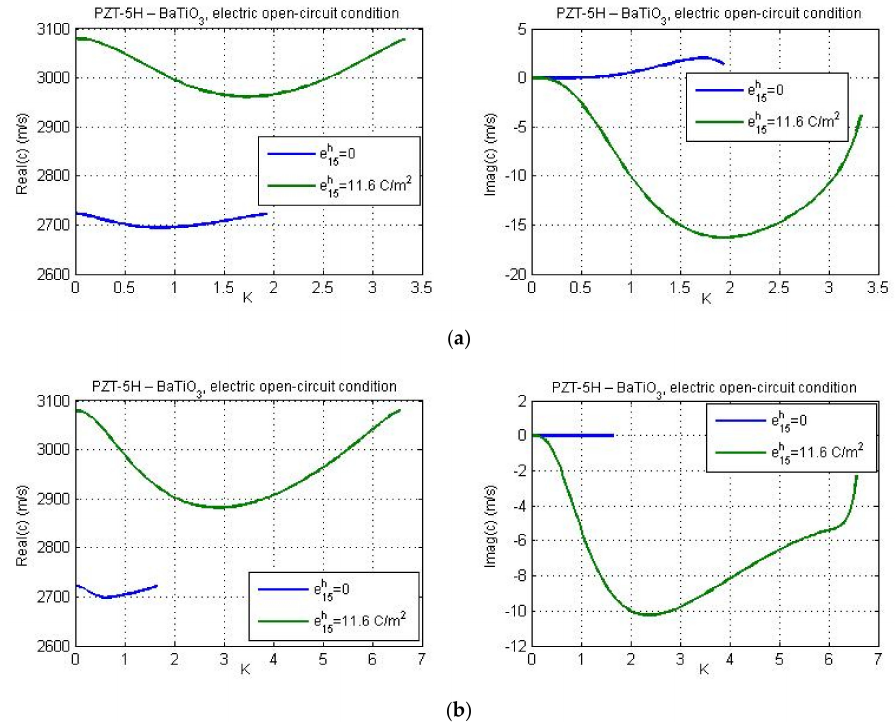
Figure 12. The dispersion curves for the material combination PZT-5H—BaTiO 3 with and without considering the effect of piezoelectric properties of the substrate under electric open-circuit conditions and for guiding layer thickness: ( a ) h = 20 nm and ( b ) h = 40